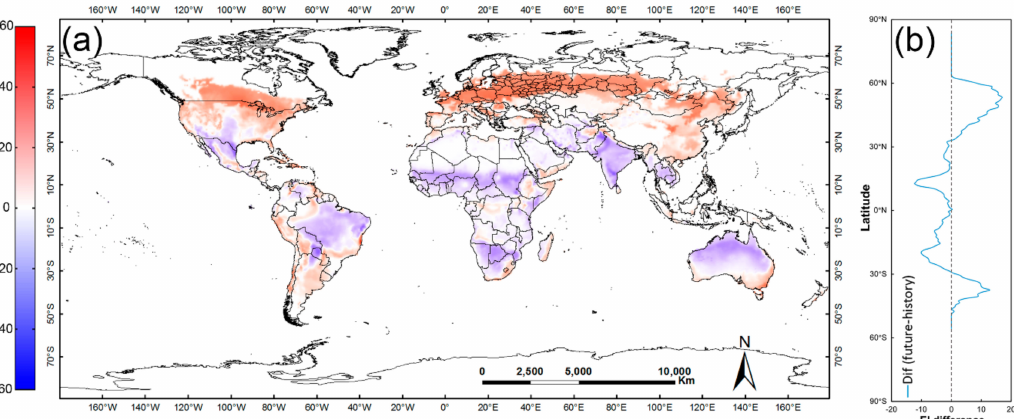
Figure 6. Impact of climate change on climatic suitability. ( a ) Di ff erences in EI values between historical and future climatic conditions. Red indicates an increase, blue indicates a decrease, and depth of color indicates the degree of change in EI values. ( b ) Changes in EI di ff erence with increasing